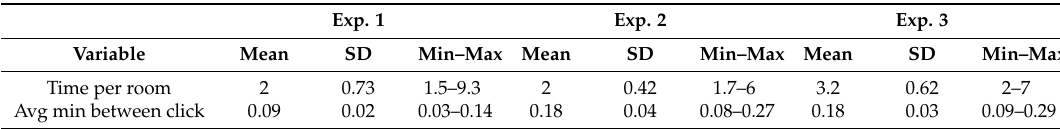
Table 1. Descriptive statistics for CYCLES Training Center difficulty variables. SD—standard deviation.